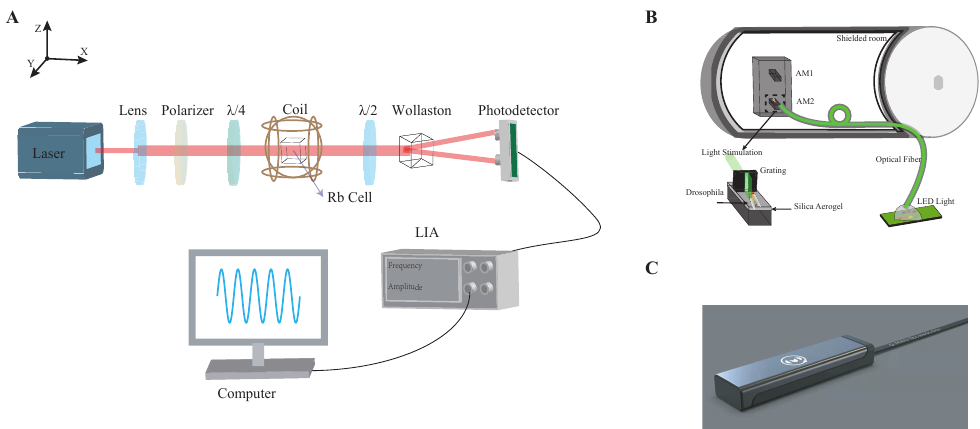
Figure 1. Configuration of the setup: ( A ) Internal structure diagram of SERF AM. ( B ) A five-layer magnetic shield was employed. Both the grating and the silica aerogel pad are made of non-magnetic materials. The thickness of the silica aerogel pad is 2 mm. During the measurement, AM 1 and AM 2 and Drosophila were placed in the shield, and the measurement direction was the z axis. ( C ) The SERF AM. The shell is made of high-temperature-resistant and non-magnetic nylon material. The center of the cell is 4 mm away from the shell. The figure has been authorized by Hangzhou Q-Mag Technology Co., Ltd., Hangzhou,